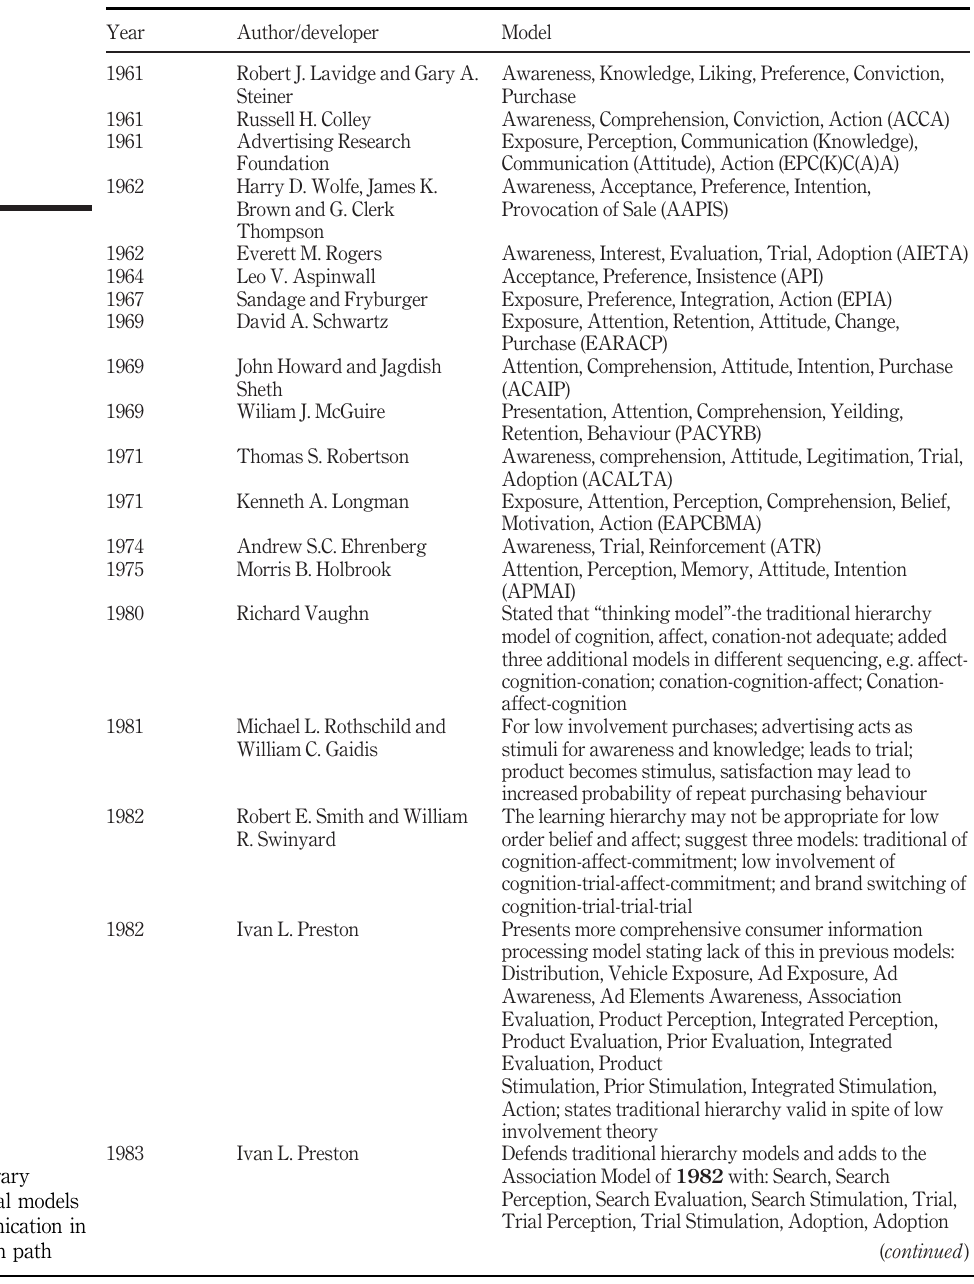
Table 2. Contemporary Hierarchical models of communication in the modern